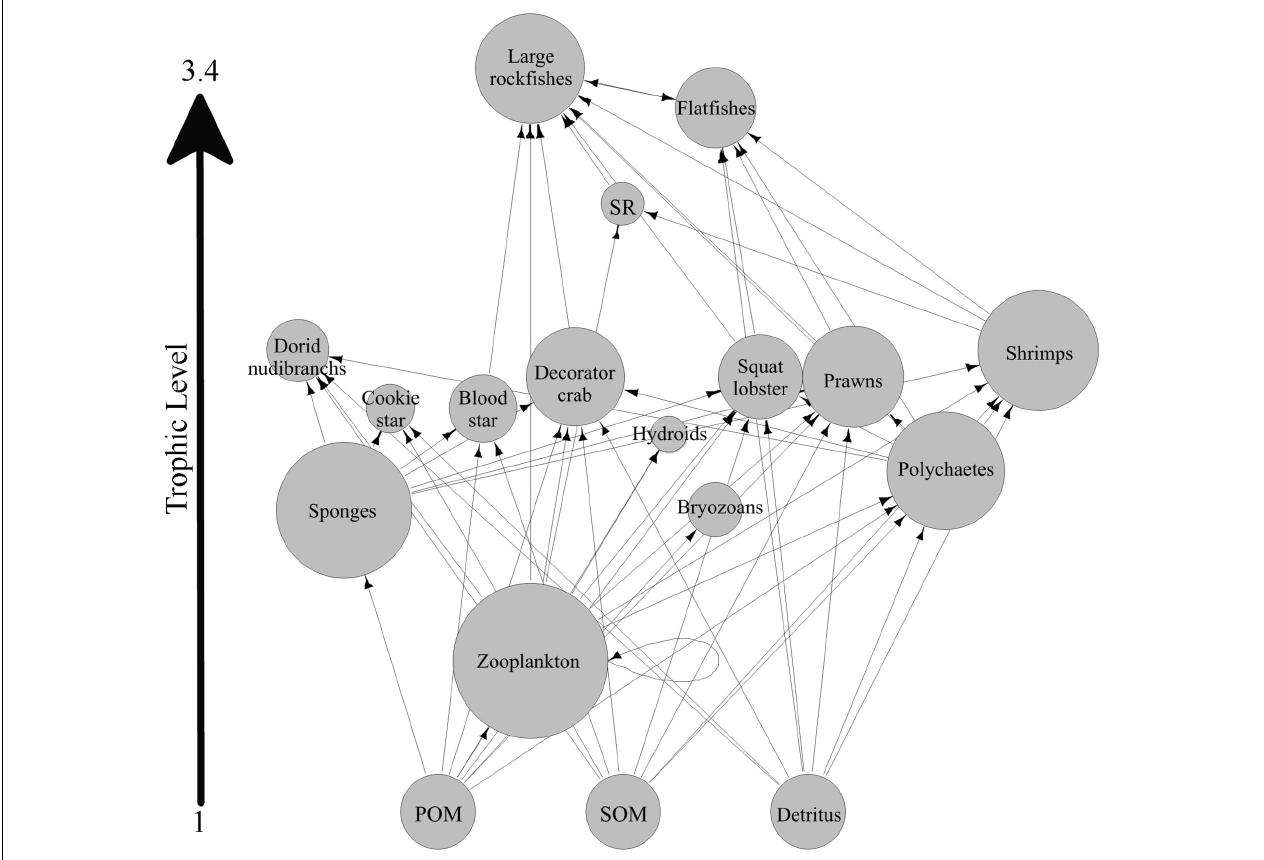
FIGURE 4 | A generalized food web for sponge reefs. Taxa were considered if they were present on two-thirds of the reefs included in this study. Two taxa, Ceramaster patagonicus and dorid nudibranchs, were also included due to previous work indicating their strong association with live reef habitat (Chu and Leys, 2010; Dunham et al., 2018b). The size of each node corresponds to its relative importance in the food web. SR represents small rockfish. Several nodes in the generalized food web represent tropho-species. When this is the case these tropho-species have been given descriptive names (e.g., Shrimps). Large and small rockfish represent tropho-species and were given names based on the relative adult size of the species in the tropho-species group. Tropho-species groupings can be found in Supplementary Table S2 .